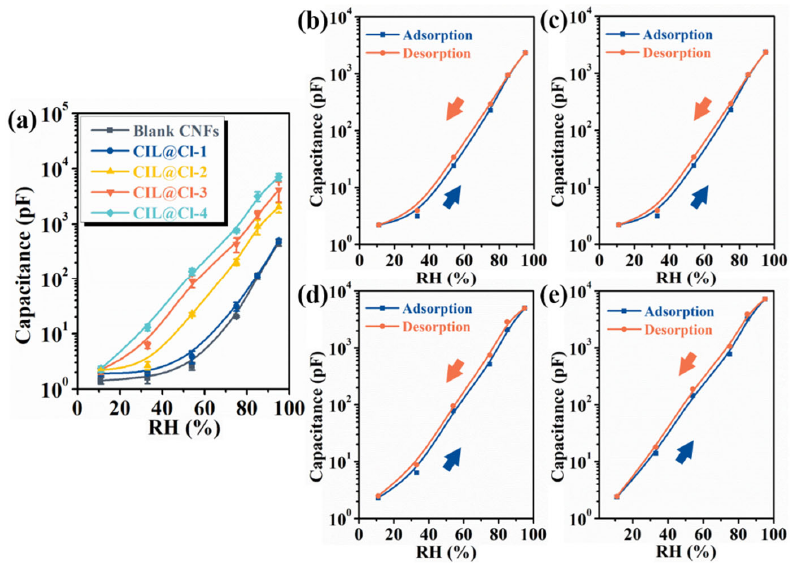
Figure 3. ( a ) Capacitance – RH curves of blank CNFs and CIL@Cl ‐ 1–4 sensors. Adsorption and desorption curves of ( b ) CIL@Cl ‐ 1, ( c ) CIL@Cl ‐ 2, ( d ) CIL@Cl ‐ 3 and ( e ) CIL@Cl ‐ 4.